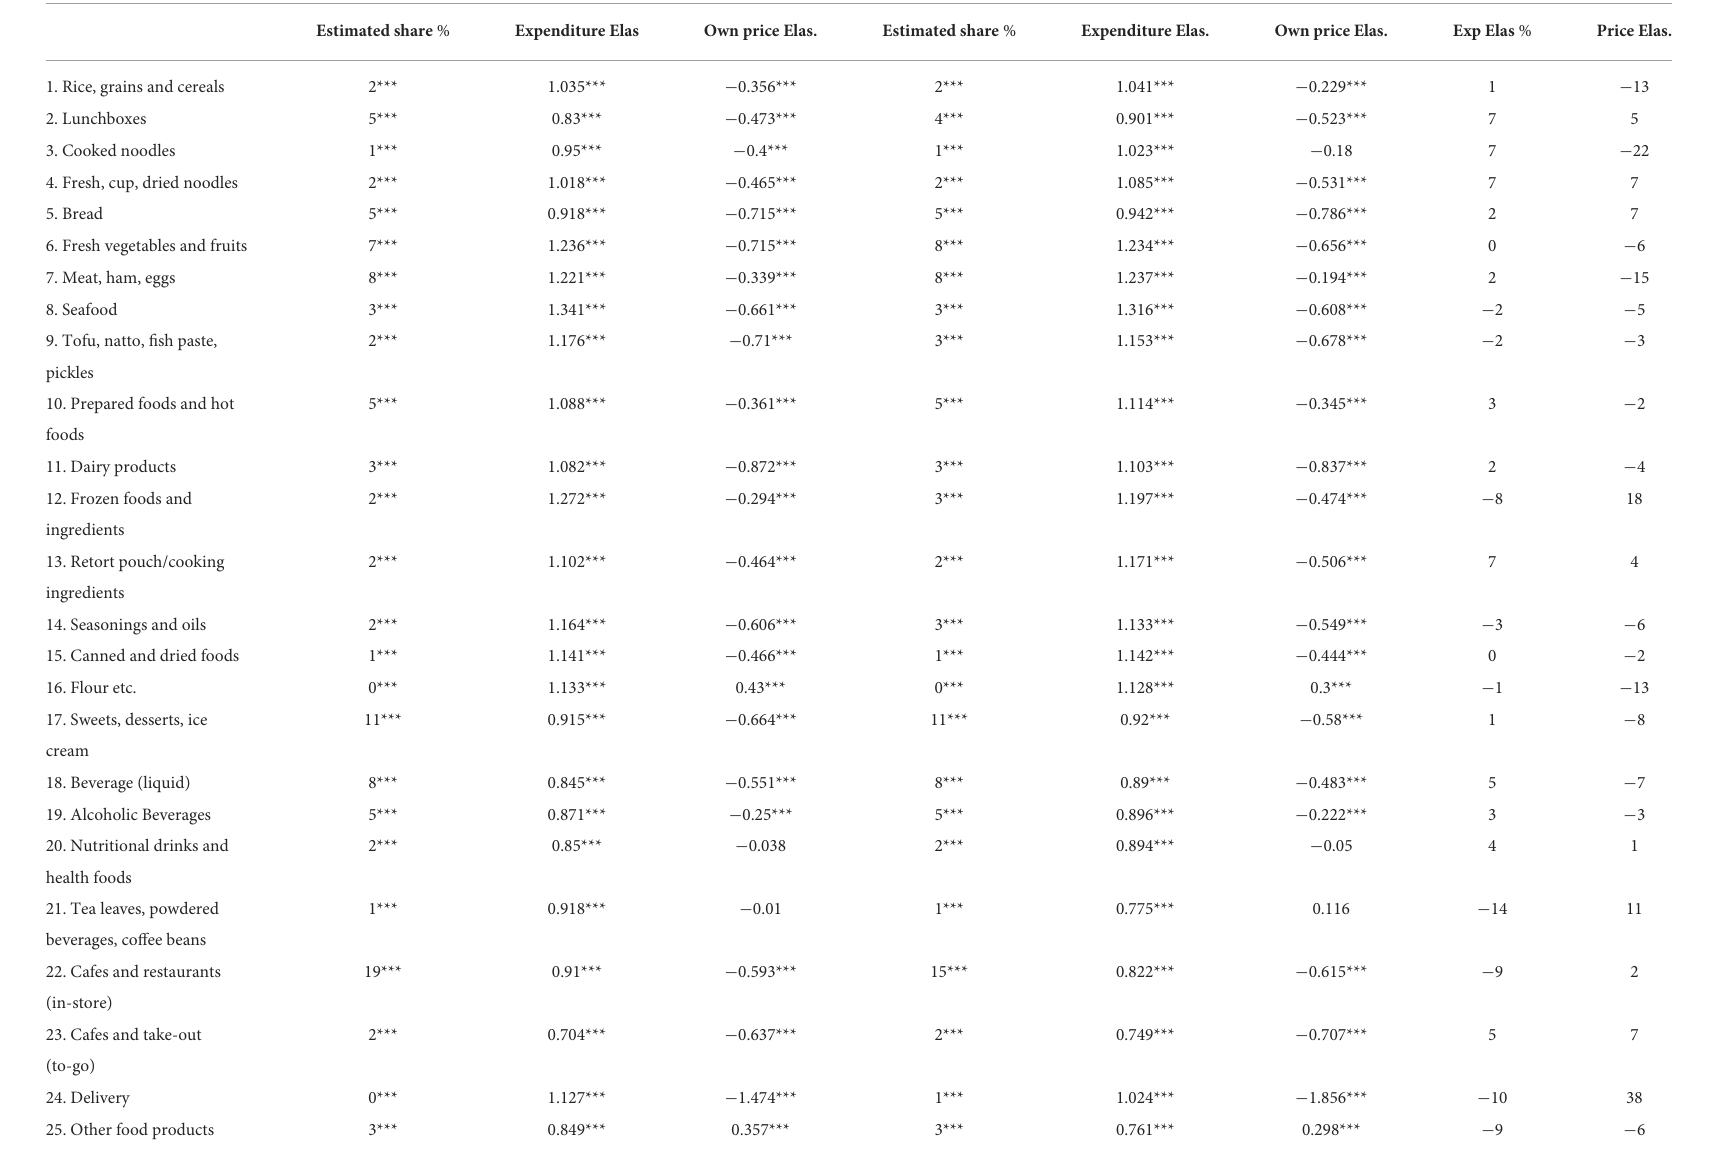
TABLE 6 Estimated elasticities of Model 2 and change rate from 2019 (Model